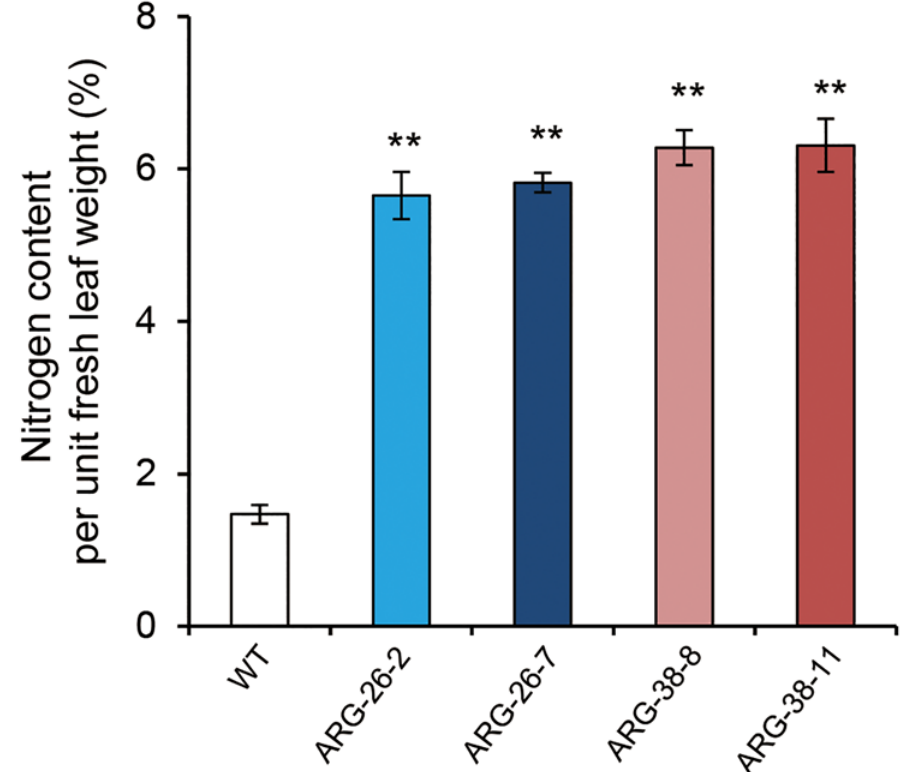
Fig 9. Comparisons of the nitrogen content per unit leaf weight in transgenic cotton compared with non-transgenic control plants under field conditions. The nitrogen content per unit leaf weight in ARG- 26-2, ARG-26-7, ARG-38-8, and ARG-38-11were significantly increased compared with the WT. ‘ WT ’ refers to non-transgenic control plants of wild type cotton. ** : P < 0.01.